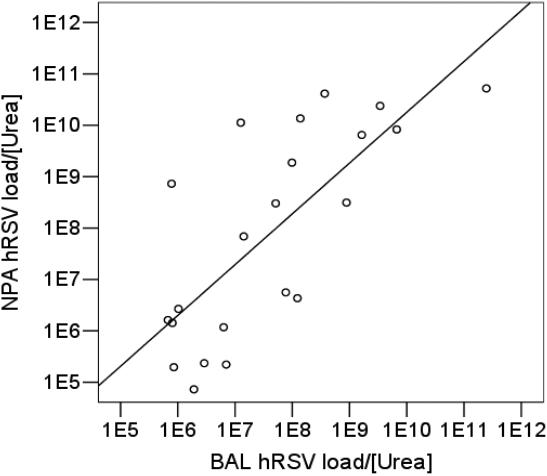
Scatter plot and best fit line between hRSV load (natural log hRSV load/[urea]) in 22 paired samples of NPA and BAL, Pearson correlation coefficient = 0.71 (R2 = 0.55, p<0.001).